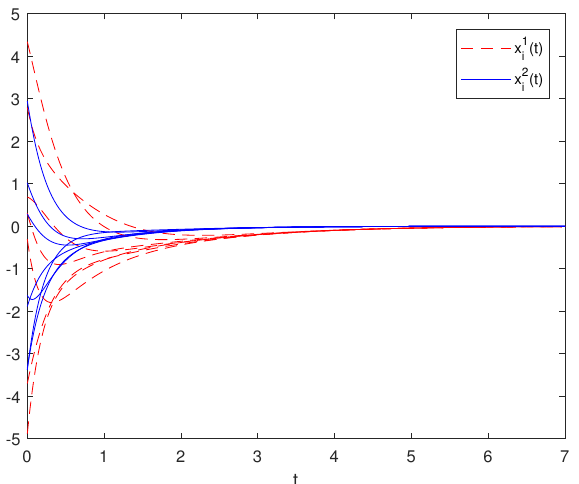
Figure 3. State trajectories of the two-layer Networks-C with 7 nodes in each layer. The trajectories of the first layer are plotted as red dashed lines, and the trajectories of the second layer are plotted as blue solid